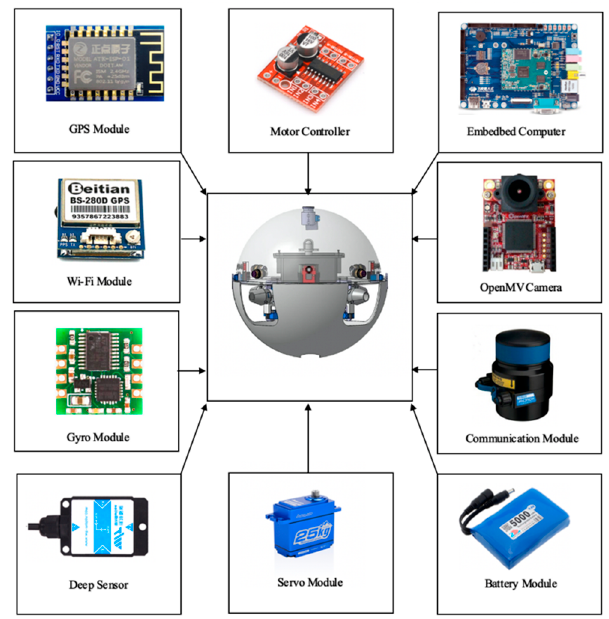
Figure 3. Composition of the electromagnetic actuation system.